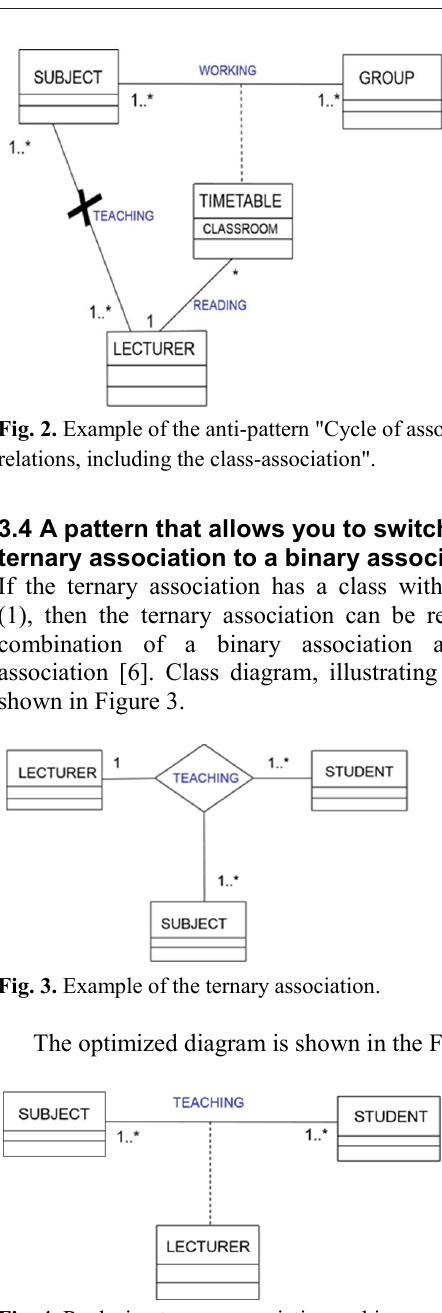
Fig. 4 . Replacing ternary association on binary and class-